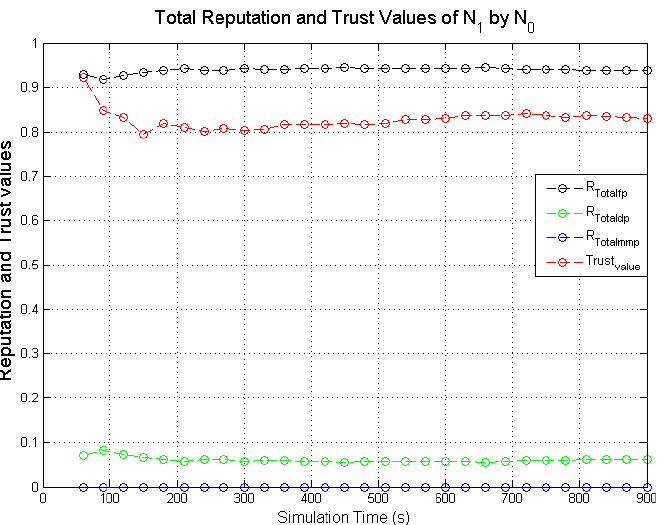
Figure 14. Nodes N 1 and N 0 are both benevolent and honest.